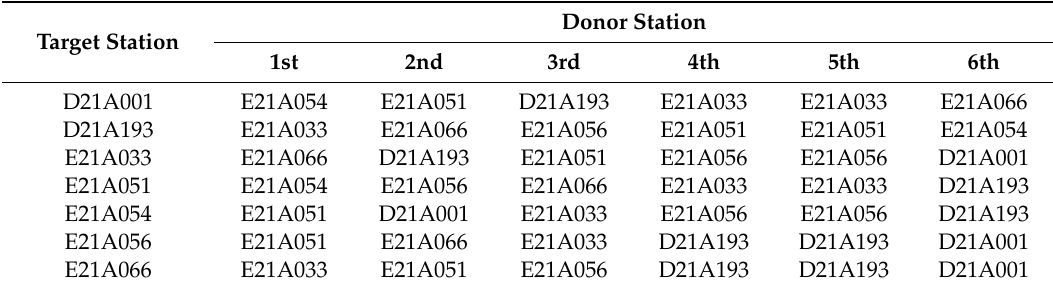
Table 11. Physically similar donor stations for each target station in the Upper Euphrates Basin. Target Station